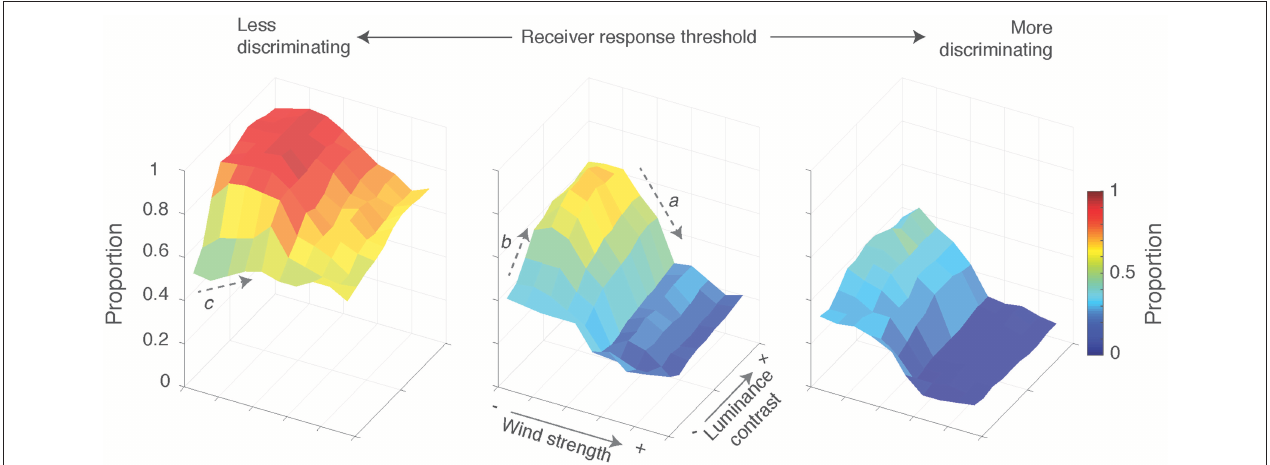
FIGURE 6 | Signal effectiveness varied as a function of prevailing wind, the luminance profile of the scene and receiver response thresholds. Surface plots show the proportion of sequence duration that exceeds a specified threshold, as a function of wind strength and luminance contrast. Increased wind strength results in greater plant motion noise, while higher luminance contrast accentuates areas of light and dark. Separate plots are shown for different receiver response threshold: low (0.25), medium (0.5), and high (0.75) levels of discrimination (from left to right, respectively). The arrows labeled a, b, and c highlight the main outcomes referred to in the text: performance declines with increased wind speed (a), performance improves at low wind speeds with increased luminance contrast (b) and at low receiver thresholds, and flat luminance profiles, performance improves from low to moderate wind speeds